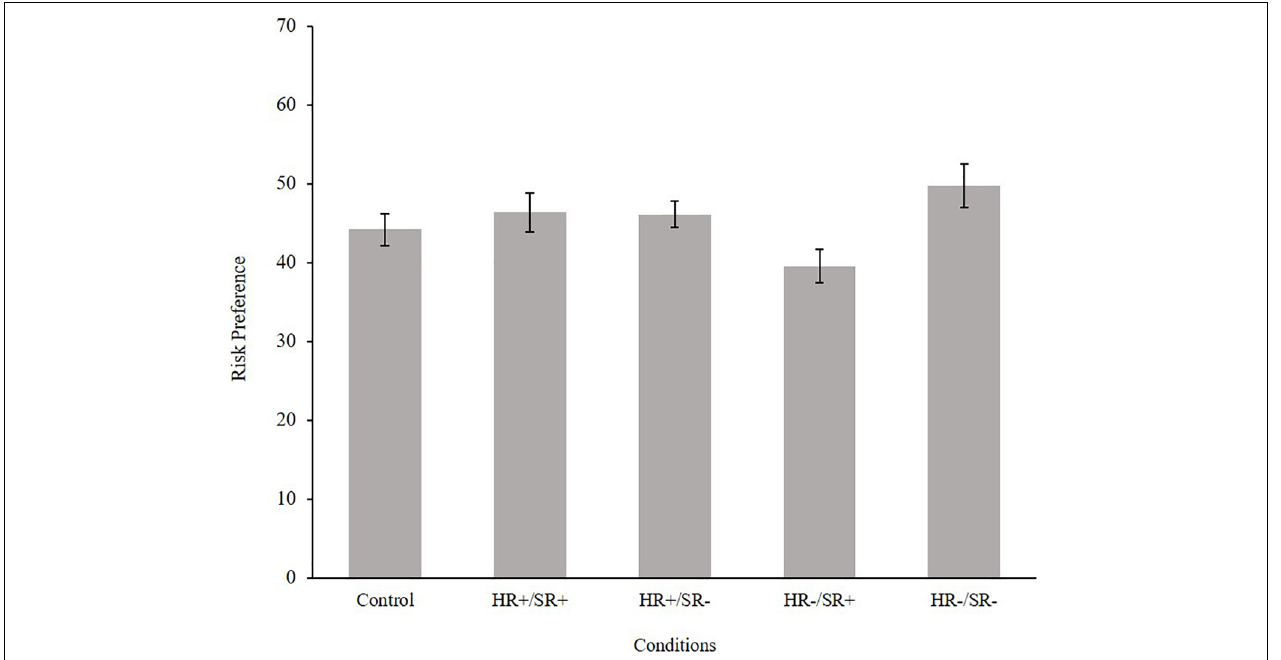
FIGURE 3 | Means and standard error of risk preference per